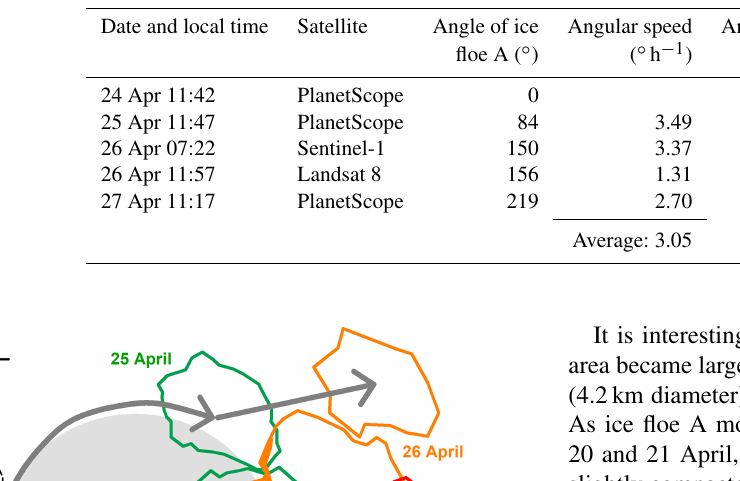
Table 3. Angle and angular speed of ice floes A and B in April 2020.